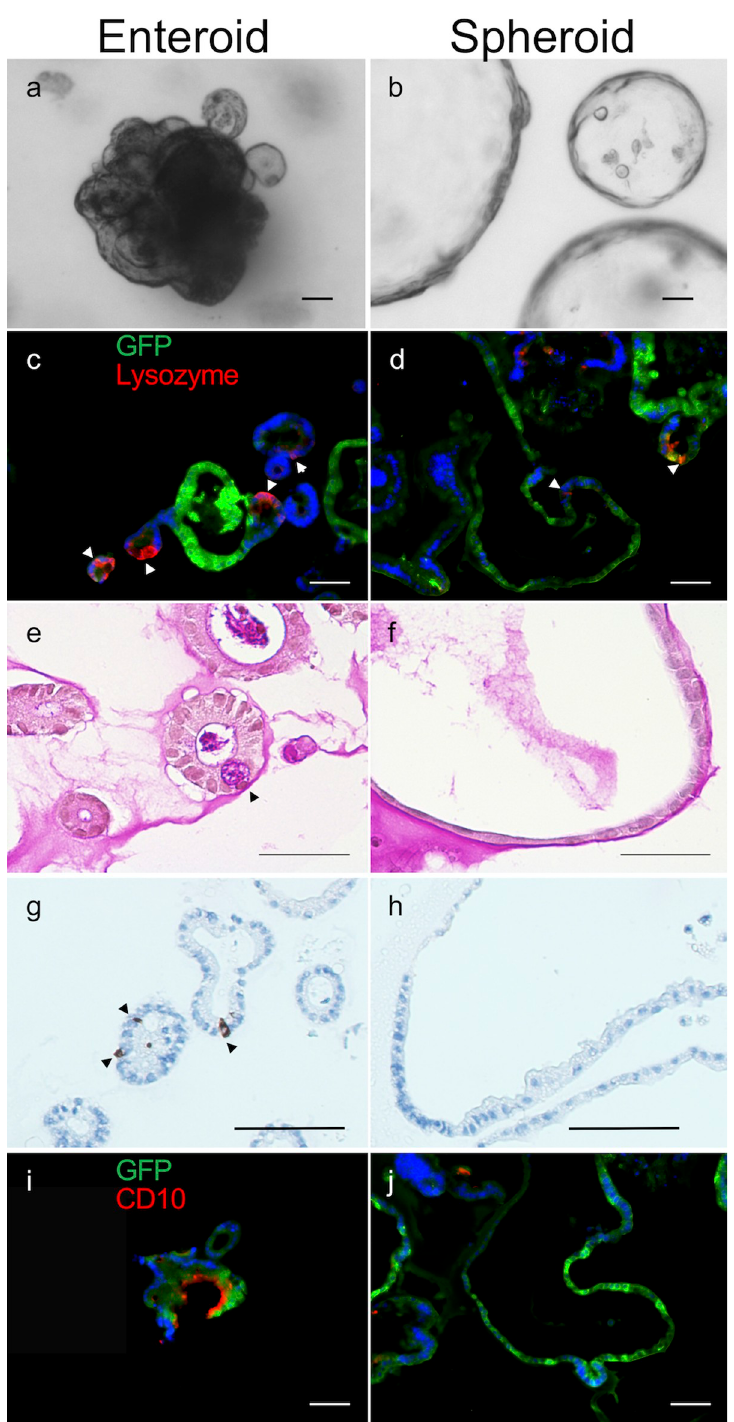
Fig 2. Characterization of murine enteroids and spheroids. (a-b) Brightfield images in culture; (c-j) immunohistochemical analysis, (c-d) lysozyme, (e-f) PAS, (g-h) synaptophysin, (i-j) CD10. The majority of the tested differentiation markers was not visualized in spheroids. Stained structures were obtained from a GFP mouse and showed expected variability in GFP expression. Scale bars, 50 μ m.